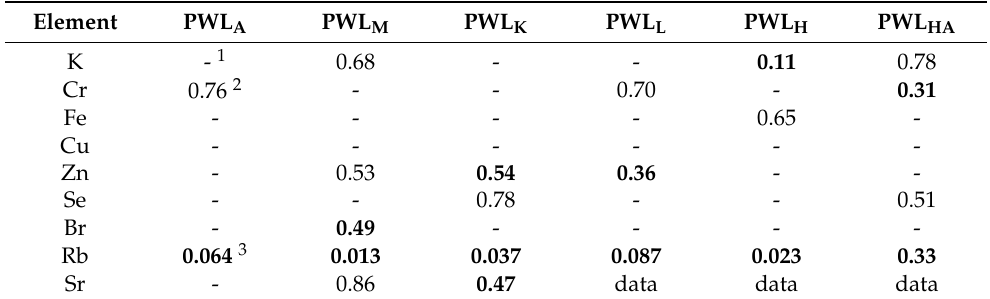
Table 1. Partial Wilks’ Lambda (PWL) values for the determined elements for adipose tissue (A), muscle (M), kidney (K), liver (L), heart (H) and heart apex (HA). Element PWL A PWL M PWL K PWL L PWL H PWL HA K - 1 0.68 - - 0.11 0.78 Cr 0.76 2 - - 0.70 - 0.31 Fe - - - - 0.65 - Cu - - - - - - Zn - 0.53 0.54 0.36 - - Se - - 0.78 - - 0.51 Br - 0.49 - - - - Rb 0.064 3 0.013 0.037 0.087 0.023 0.33 Sr - 0.86 0.47 data data